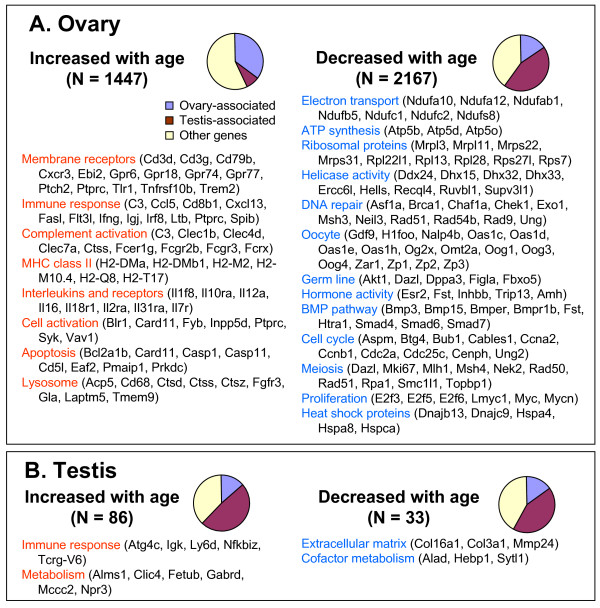
Functional groups of genes affected by age. (A) Ovary and (B) testis. Pie charts show the proportion of genes that were over-expressed either in ovary or testis by at least two-fold. Functional categories of genes were assembled from GO annotations and from PubMed.